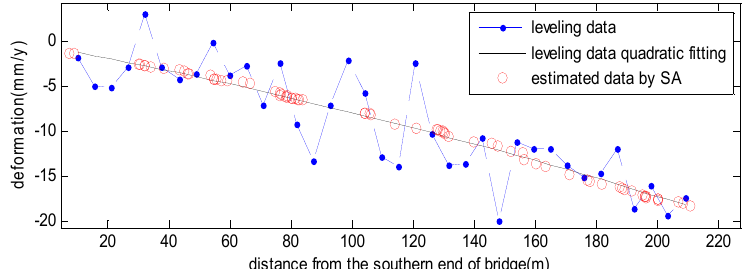
Figure 7. The linear deformation profile along the bridge comparison between leveling (blue dot line), and the estimated result by the SA-based algorithm (red circle).